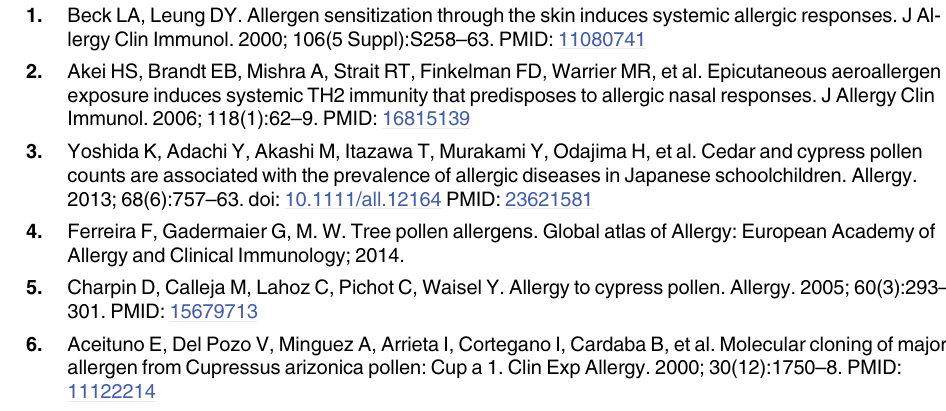
S1 File. Table A. Demographic and diagnostic data of pectate lyase allergic patients included in the study. Table B. Demographic and diagnostic data of Italian pectate lyase allergic patients involved in the microarray